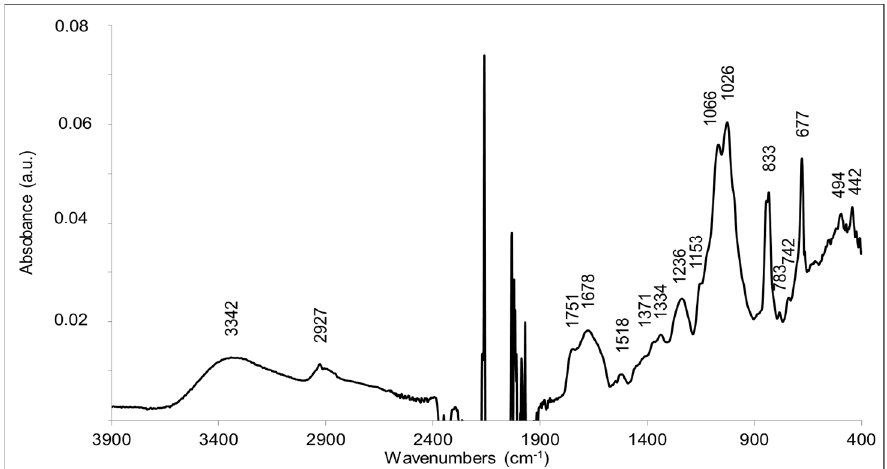
Figure 7. FTIR spectrum of the extracted EPS from R. tataouinensis TTB310 cysts. The spectrum was recorded in the 3900–400 cm − 1 range with a 4 cm − 1 resolution using an ATR device (SensIR technologies, CT) equipped with a 9-bounce diamond microprism and ZnSe optics. The 2400–1900 cm − 1 region cannot be exploited due to the absorption of CO 2 and the strong absorption of the diamond material.